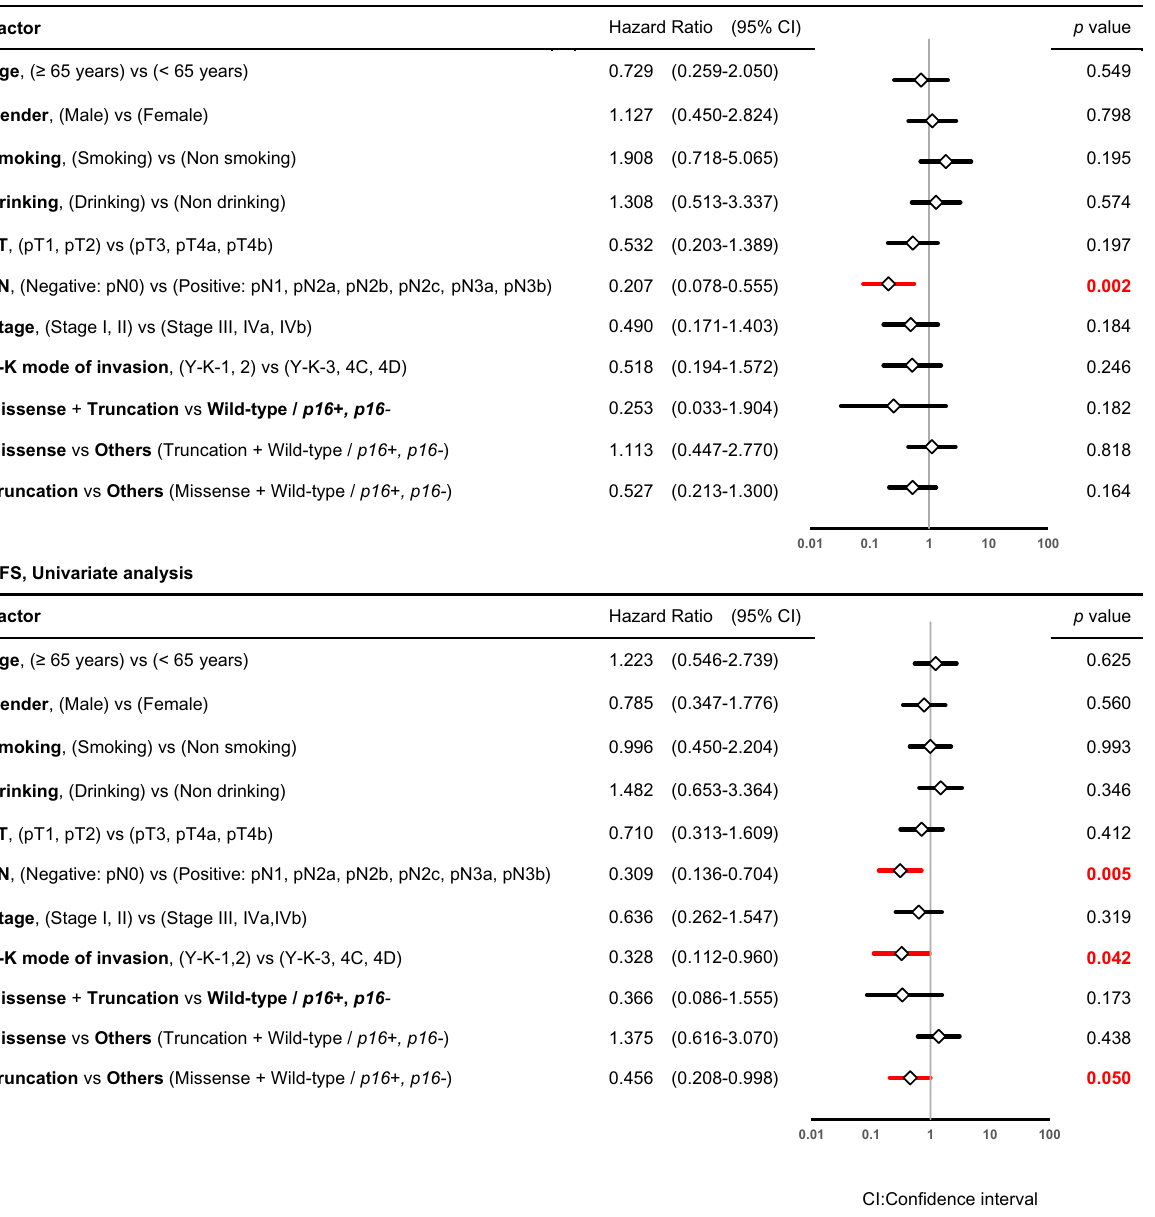
Table 5. Characteristics of patients and the p53 mutational spectrum as risk factors for OS and DFS (univariate